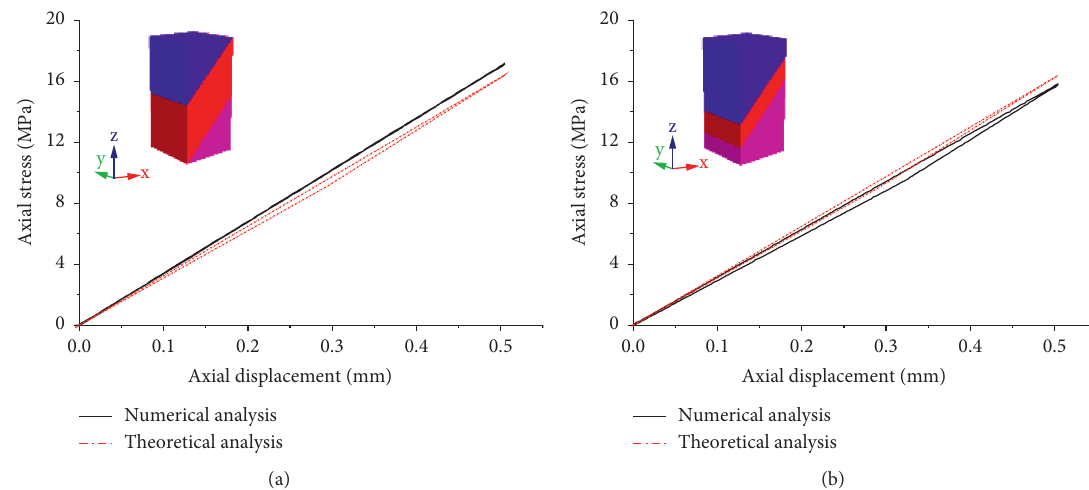
Figure 6: Comparison of numerical and theoretical results of coal body containing two joints. (a) When two joints are located at two ends of the model. (b) When two joints are situated in the middle of the model.